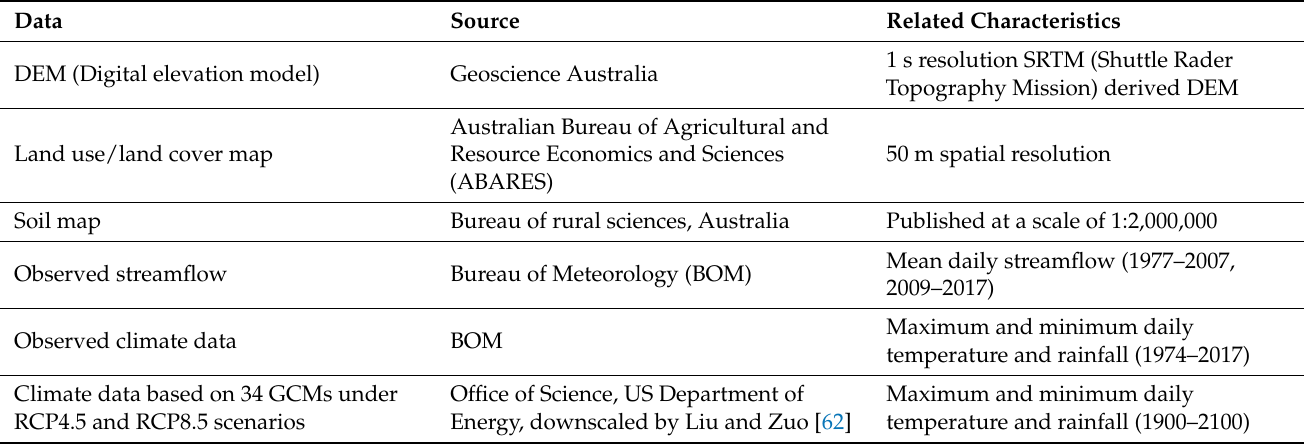
Table 1. Data input for the SWAT model, data sources, and related